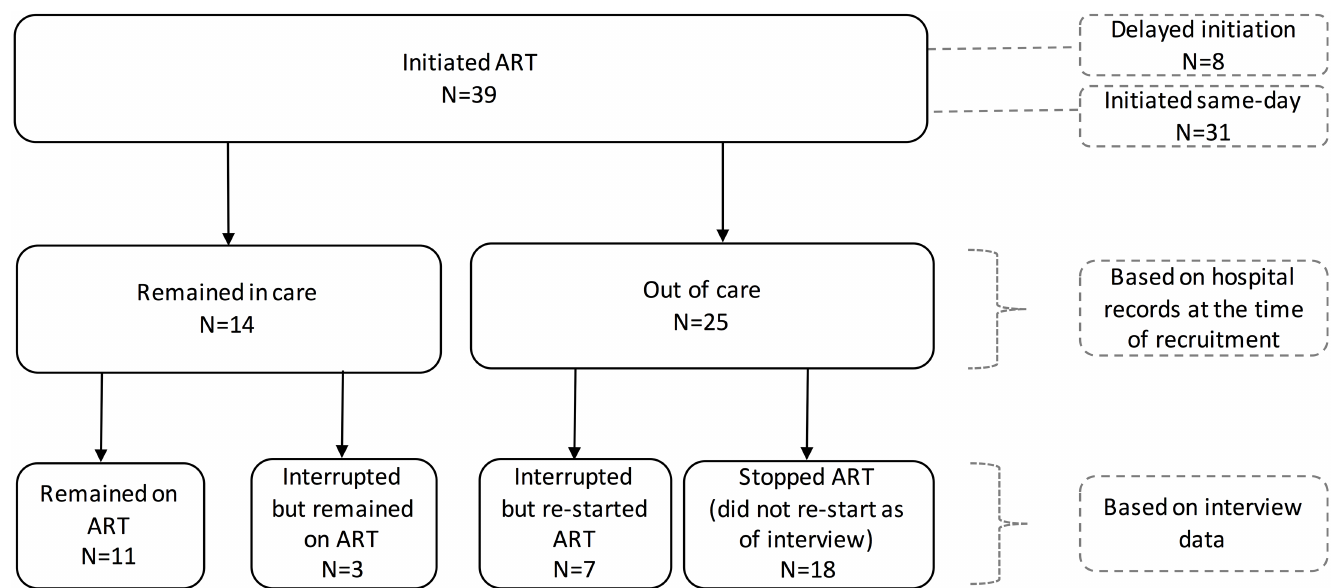
Fig 1. Study sample of pregnant and lactating women who initiated Option B+ servicesat Bwaila Family Health Unit (BFHU), Lilongwe, Malawi. https://doi.org/10.1371/journal.pone.0179838.g001 (Fig 1). The 10 study participants who reported stopping and re-starting ART mentioned HCP